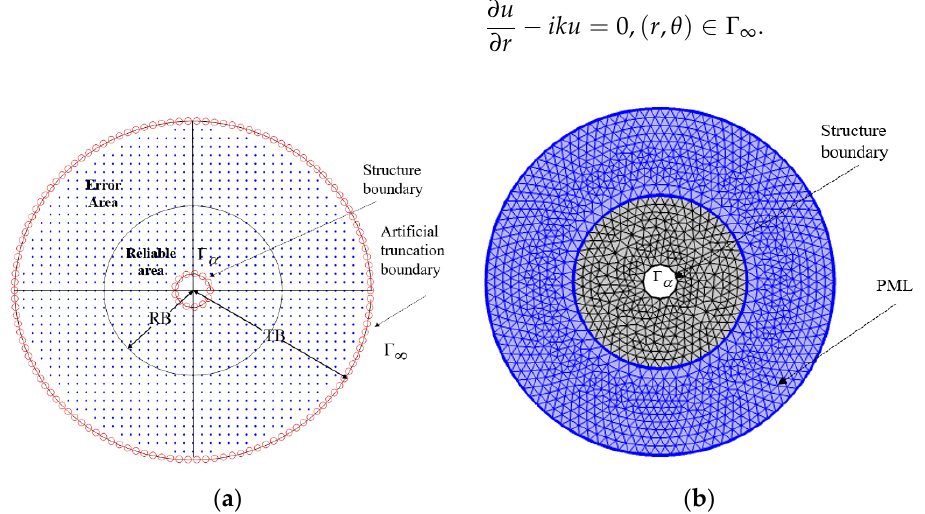
Figure 4. Sketch of ( a ) the computational domain truncated by the absorbing boundary Γ ∞ including the error region and the reliable region; ( b ) The computational domain used in the finite element method (FEM) (COMSOL) including the perfectly matched layer (PML) region.